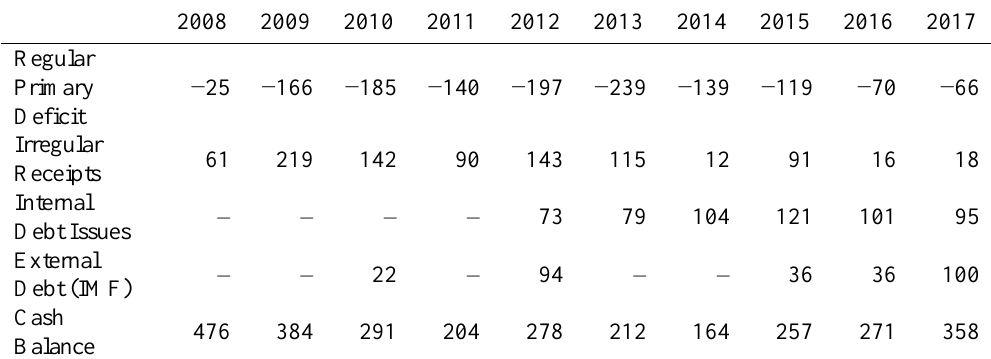
Table 6. Regular Primary Deficit and its Financing (millions of